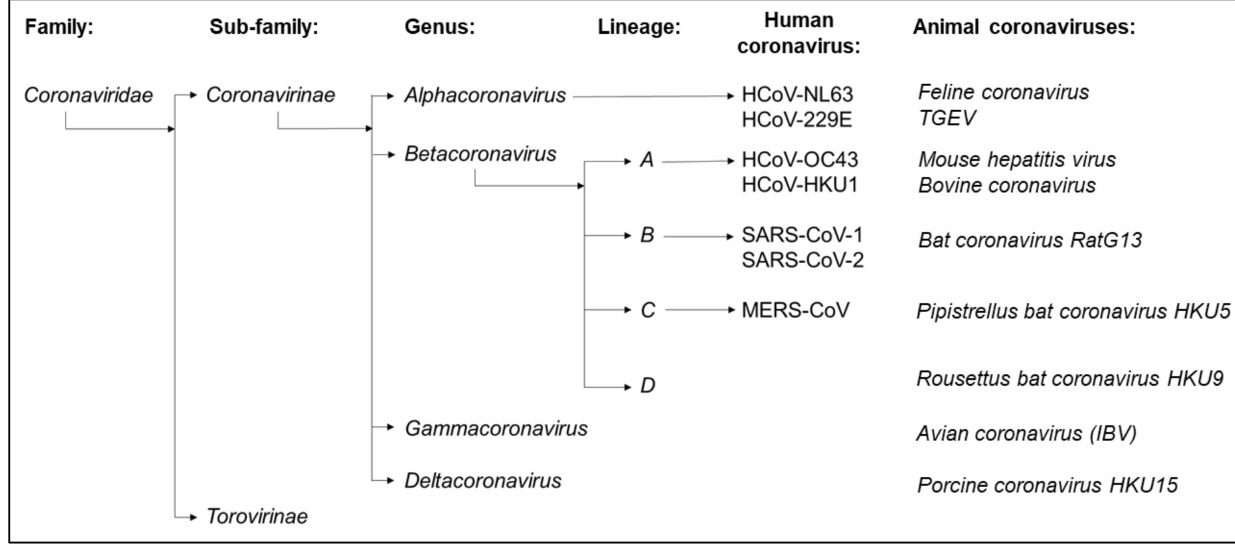
Figure 1. The seven human coronaviruses belong to either the alphacoronavirus or betacoronavirus genus of the Coronaviri- nae sub-family of the Coronaviridae. The alphacoronaviruses include seasonal coronaviruses HCoV-229E and HCoV-NL63, whilst the betacoronaviruses include high pathogenicity coronaviruses such as SARS-CoV-1, SARS-CoV-2 and MERS-CoV in addition to seasonal coronaviruses HCoV-HKU1 and HCoV-OC43. The Coronavirinae are ubiquitous pathogens of mammalian and avian species; each of the seven human coronaviruses emerged from independent zoonotic spillover